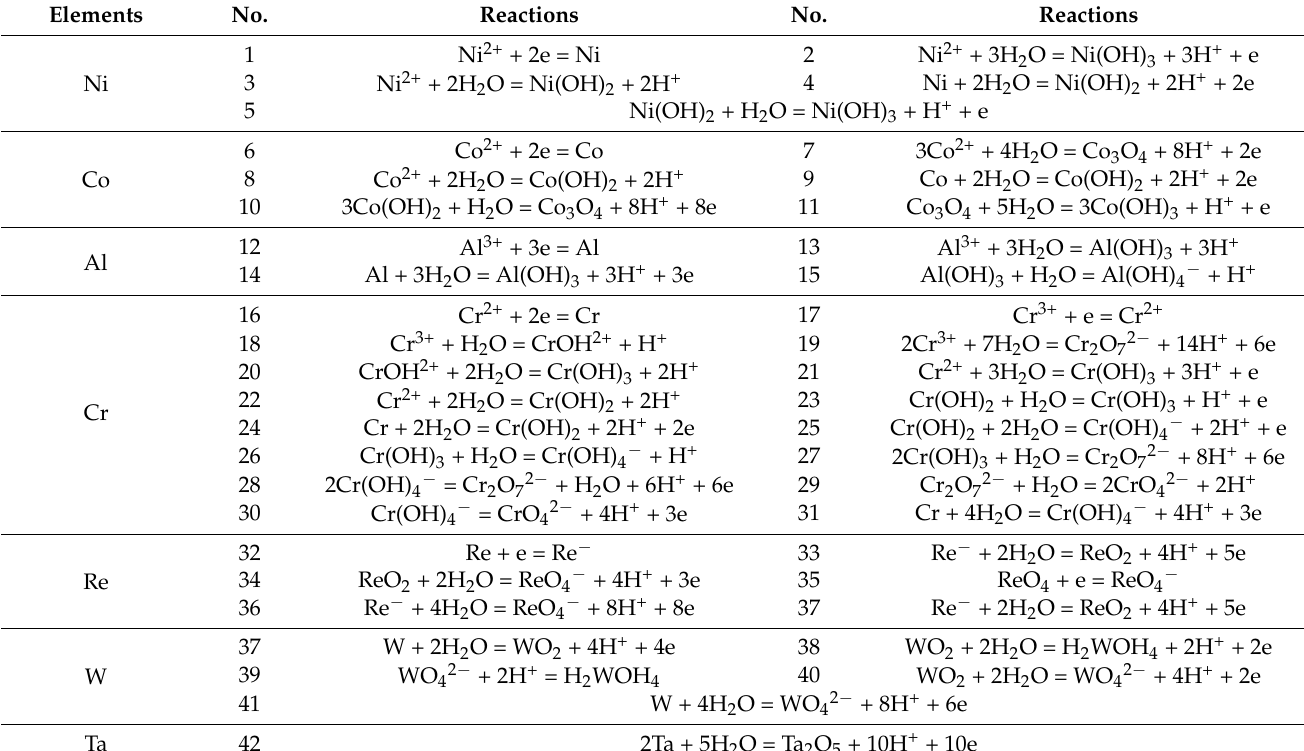
Table 1. The main reactions in the M (Ni, Co, Al, Cr, Re, W, Ta)-H 2 O system. Elements No. Reactions No.